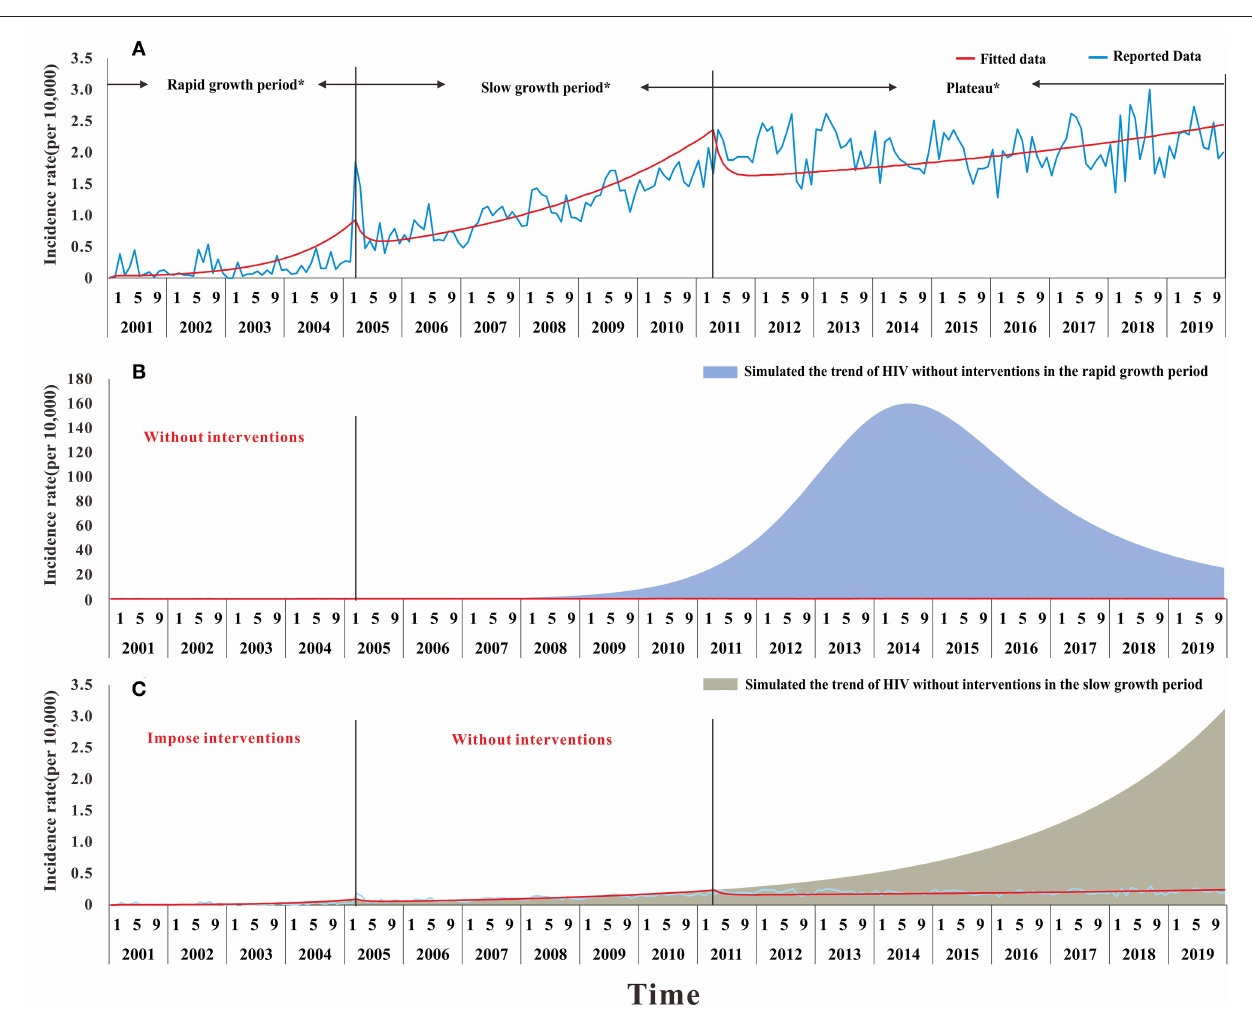
FIGURE 9 | The result of simulation prevention and control effect of HIV in Nanning during the twenty years. (A) The result of the model fitted and different stage in the development of HIV, Rapid growth period: from January 2001 to March 2005; Slow growth period; from April 2005 to April 2011; Plateau: from May 2011 to December 2019; (B) the result of the simulated trend by using the transmissibility of rapid growth period without interventions; (C) the result of the simulated trend by using the transmissibility of slow growth period in the condition of without interventions in the second stage but taking interventions in the rapid growth